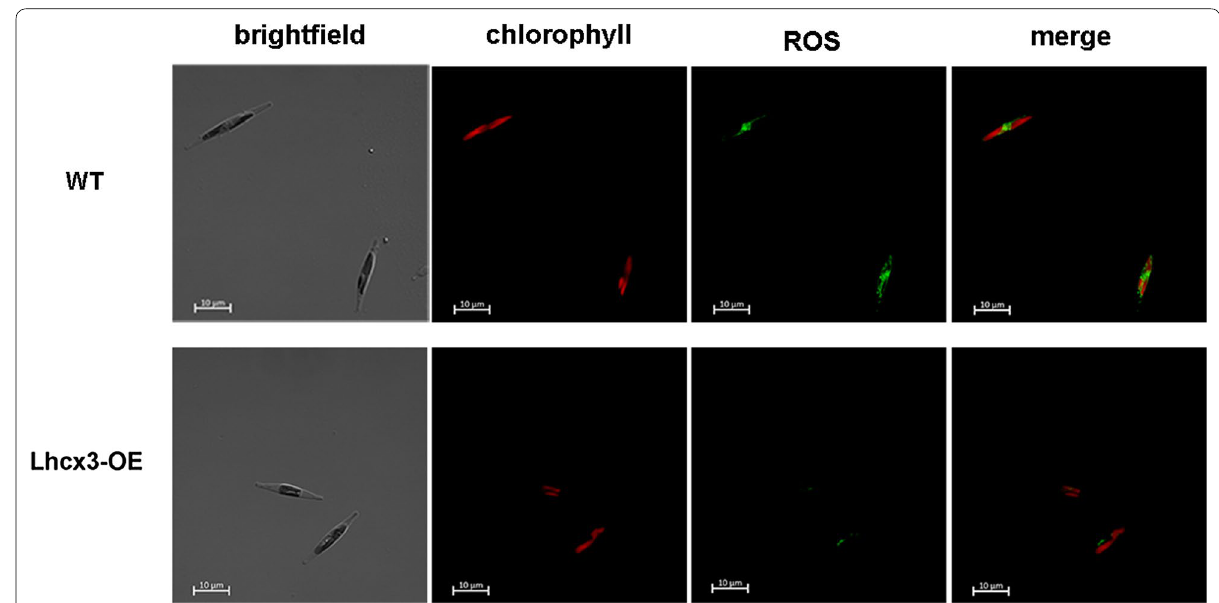
Fig. 8 Confocal microscopy images of wild type (WT) cells and PtLhcx3 overexpression lines for detecting reactive oxygen species (ROS). From left to right, Brightfield; chlorophyll autofluorescence; ROS fluorescence; flurescence overlay. Scale bars represent 10 μm